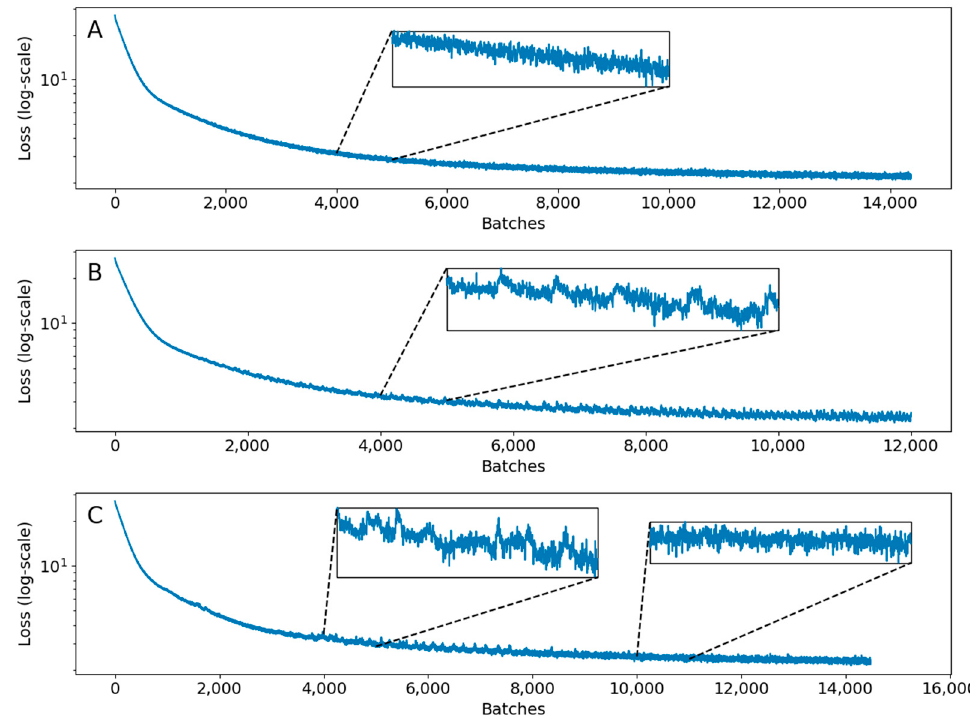
Figure A11. Examples of training losses. ( A ) Example where the loss decreases steadily apart from the smaller fluctuation in the random character. ( B ) Example where the loss shows instability in the form of a low-amplitude sawtooth pattern which represents movement between local minima with different topologies for the low-dimensional representation. ( C ) Example where the loss shows transient instability but then stabilizes and converges to one topology.